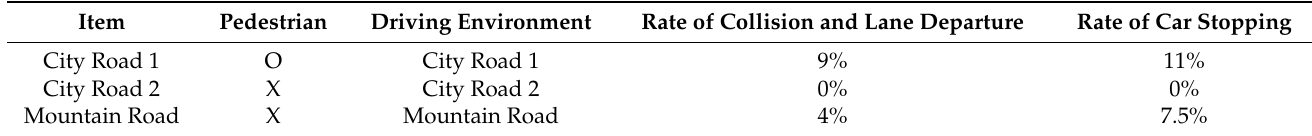
Table 3. Comparison of collisions by driving environment between the existing method and the proposed algorithm. Item